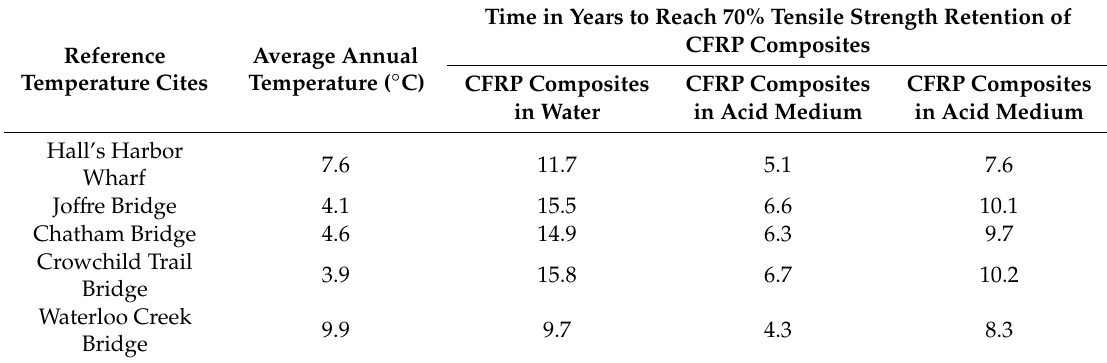
Table 9. Long- term prediction results of CFRP composites at di ff erent mean annual temperatures.